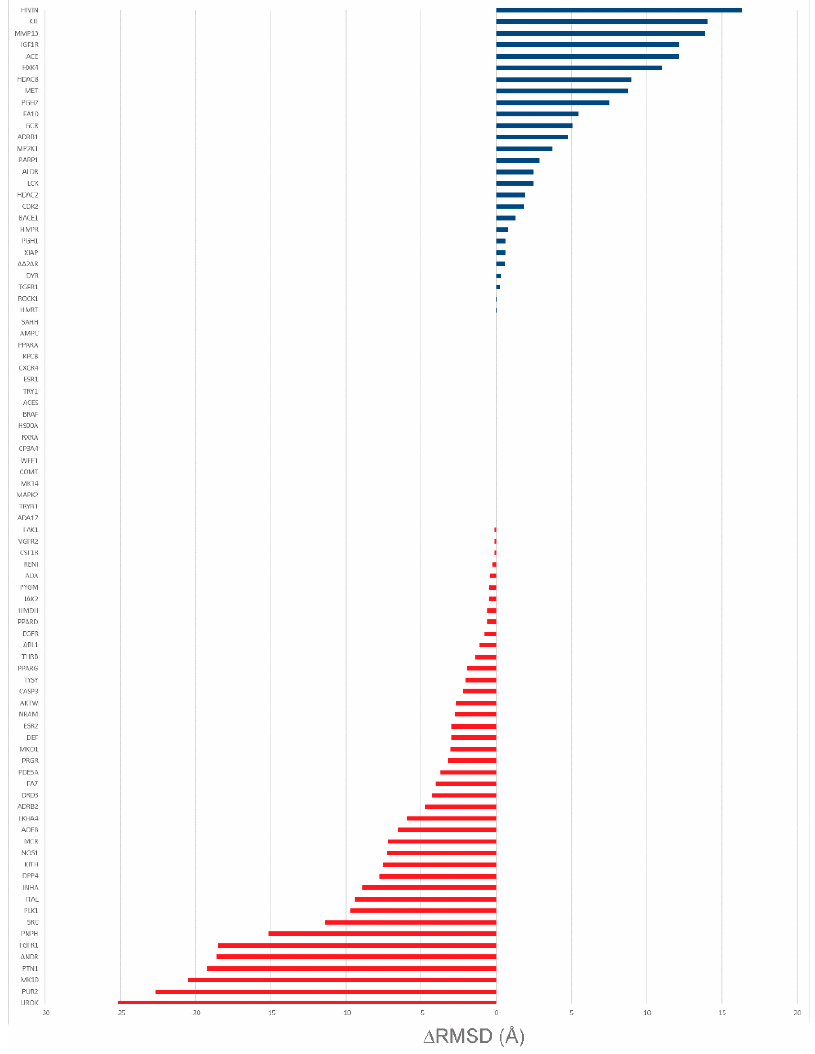
Figure 8. ∆ RMSD comparison of AutoDock Vina and CS. Blue bars indicate cases in which the top scoring pose identified by CS is closer to the co-crystallized ligand than the one identified by AutoDock Vina. Red bars indicate the opposite cases.